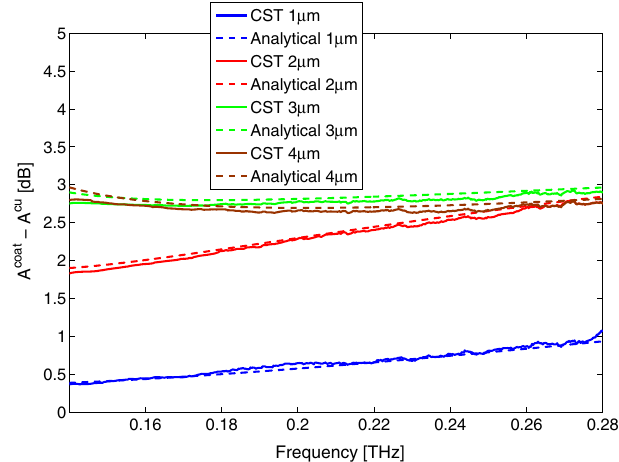
FIG. 10. DUT: relative attenuation of propagating mode on the slab for different coating thicknesses with σ Comparison between analytical formulas (dashed line) and CST frequency domain simulations (full